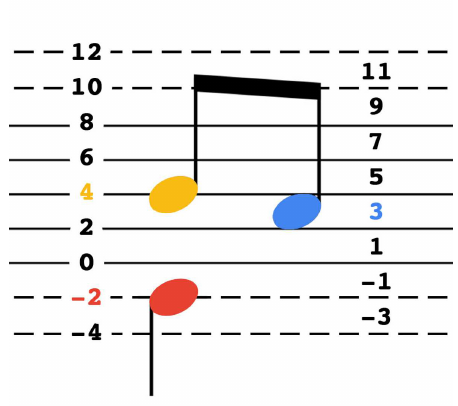
Figure 4. Encoding of the pitch with a vertical distance. The numbers in the figure represent the labels of the pitch. The label of the red headnote is 2, and the label of the yellow headnote is 4. −